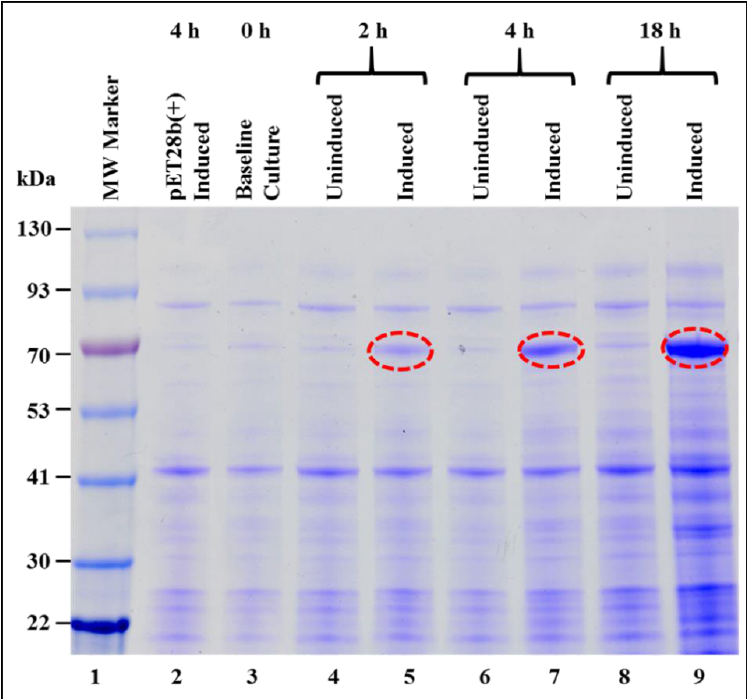
Figure 2. Expression of recombinant Pr77 Gag -His 6 -tag fusion protein in Escherichia coli (E. coli) . Sodium dodecyl sulfate-polyacrylamide gel electrophoresis (SDS-PAGE) analysis showing full length Pr77 Gag -His 6 -tag fusion protein expressed from AK1 in total bacterial cell lysates at 0, 2, 4, and 18 h post IPTG-induction and un-induced BL21(DE3) bacterial cells. The bacterial cells were grown at 37 °C overnight, but following IPTG induction, cultures were grown sub-optimally at 28 °C. MW: molecular weight.